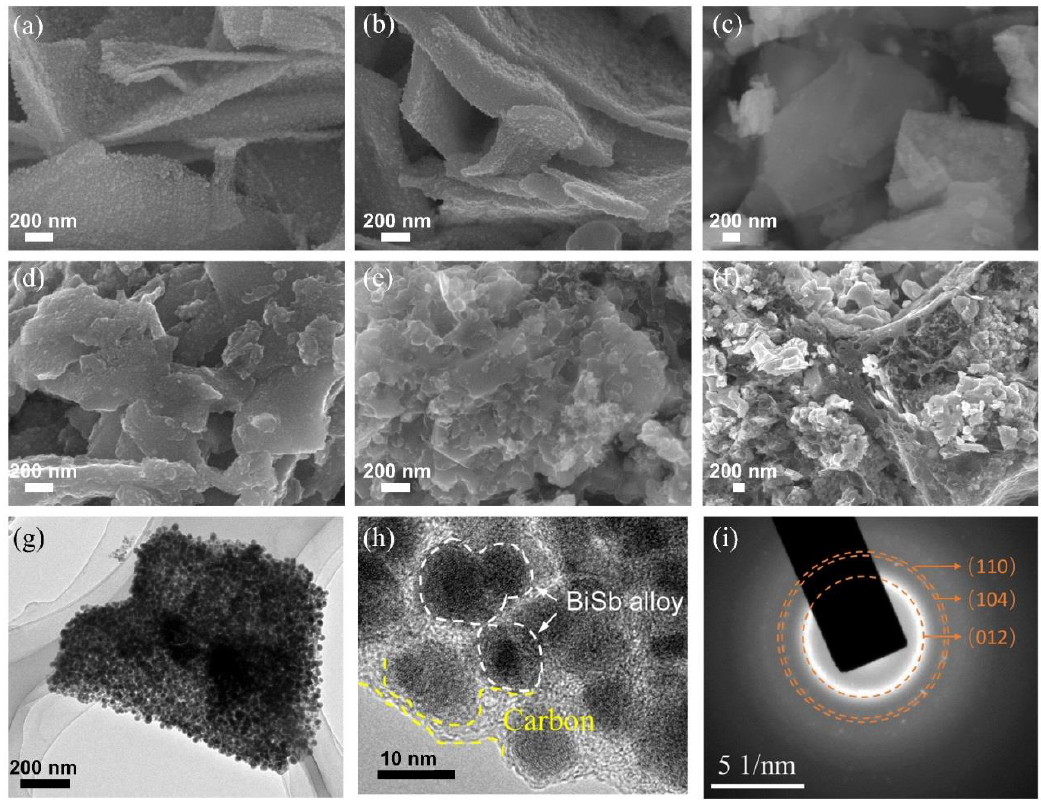
Figure 1. SEM images of the ( a ) Bi@C, ( b ) Bi 3 Sb 1 @C, ( c ) Bi 1 Sb 1 @C, ( d ) Bi 2 Sb 3 @C, ( e ) Bi 1 Sb 3 @C, and ( f ) Sb@C samples. ( g ) TEM image, ( h ) HRTEM image, and ( i ) SAED pattern of Bi 1 Sb 1